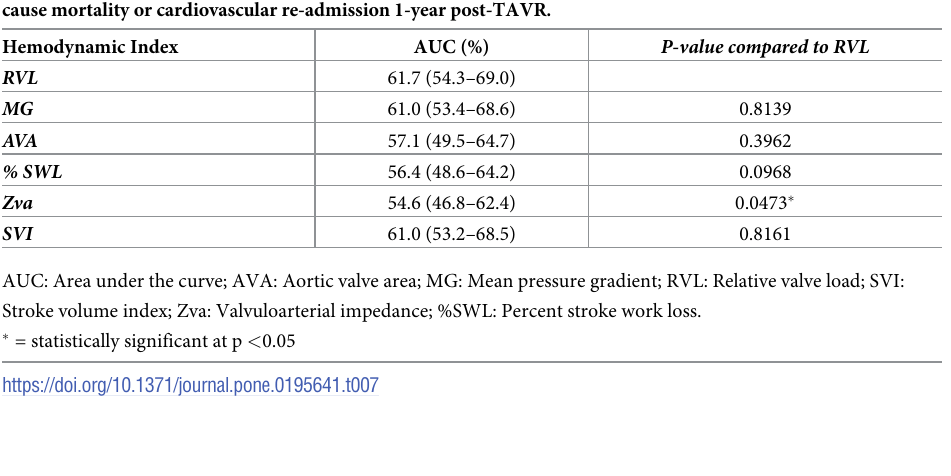
Table 7. Receiver operator curve analysis of the hemodynamic indices for predicting the combined outcome of all cause mortality or cardiovascular re-admission 1-year post-TAVR. Hemodynamic Index